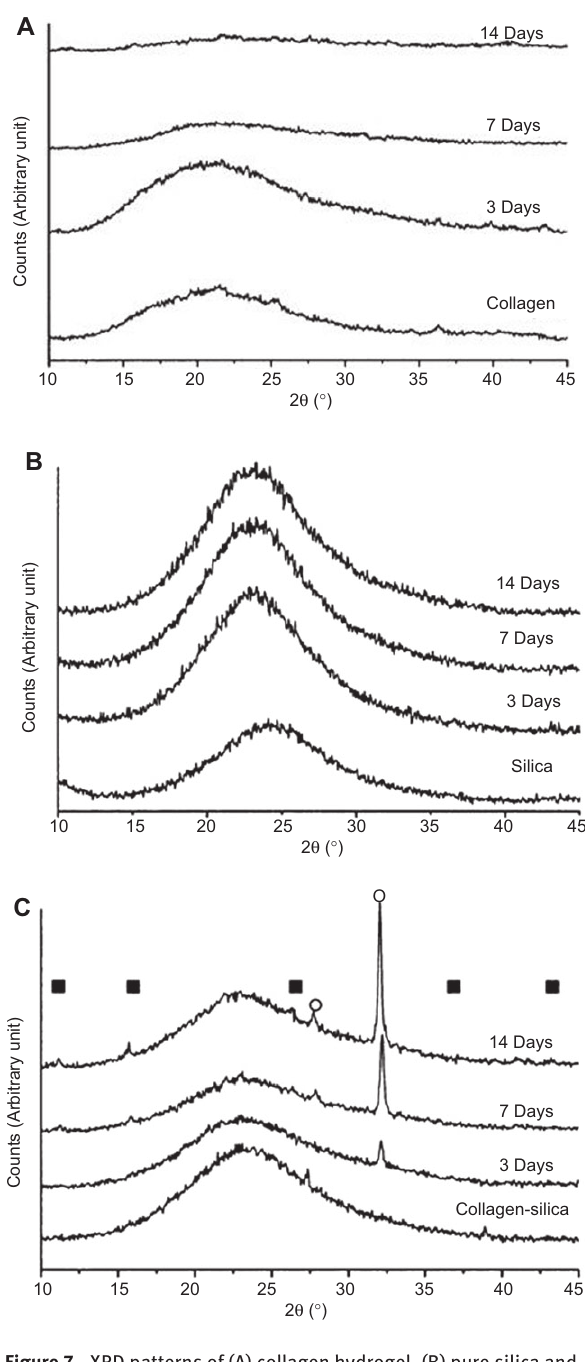
Figure 7 XRD patterns of (A) collagen hydrogel, (B) pure silica and (C) collagen-silica composite hydrogel surfaces after 0, 3, 7 and 14 days of immersion in SBF solution [( (cid:2) ) α -TCP or OCP and ( ○ ) Ca (Si O )(OH) ], according to Eglin et al. [14] . Reproduced with 4 3 9 2 permission from